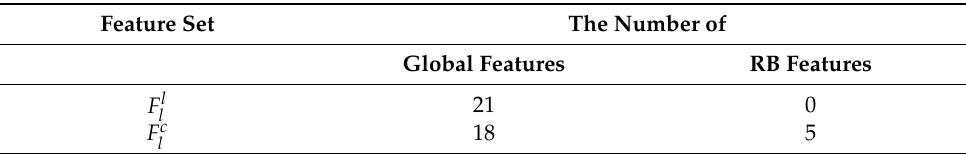
Table 10. The number of global features, RB features in the two feature sets F l CIAA respectively.